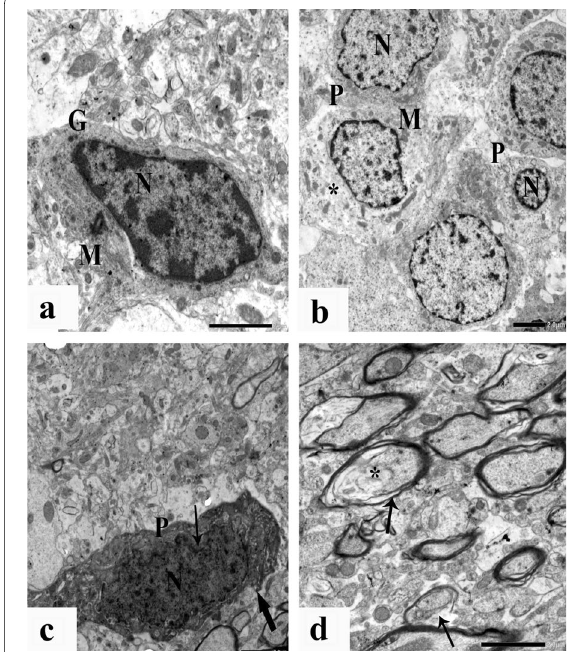
Fig.10 Electron micrographs of the cerebral cortex obtained from rats treated with paroxetine and ALA showing: a & b mostly normal pyramidal cell (P) with apical dendrite (arrow), normal nucleus (N), mitochondria (M), and free ribosomes (R). c : granule cell had rounded nucleus (N), and rough endoplasmic reticulum (rER). d : myelinated axon with regular myelin sheath (thin arrow), homogenous axoplasm (*) contains normal mitochondria (thick arrow) and few axons with irregular contour (red